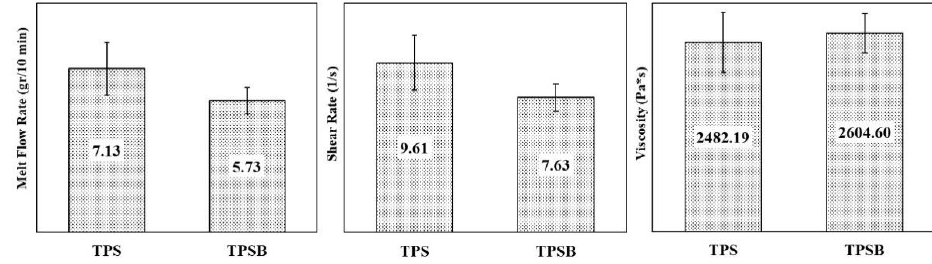
Figure 6. MFR, shear rate and viscosity TPS and TPSB.